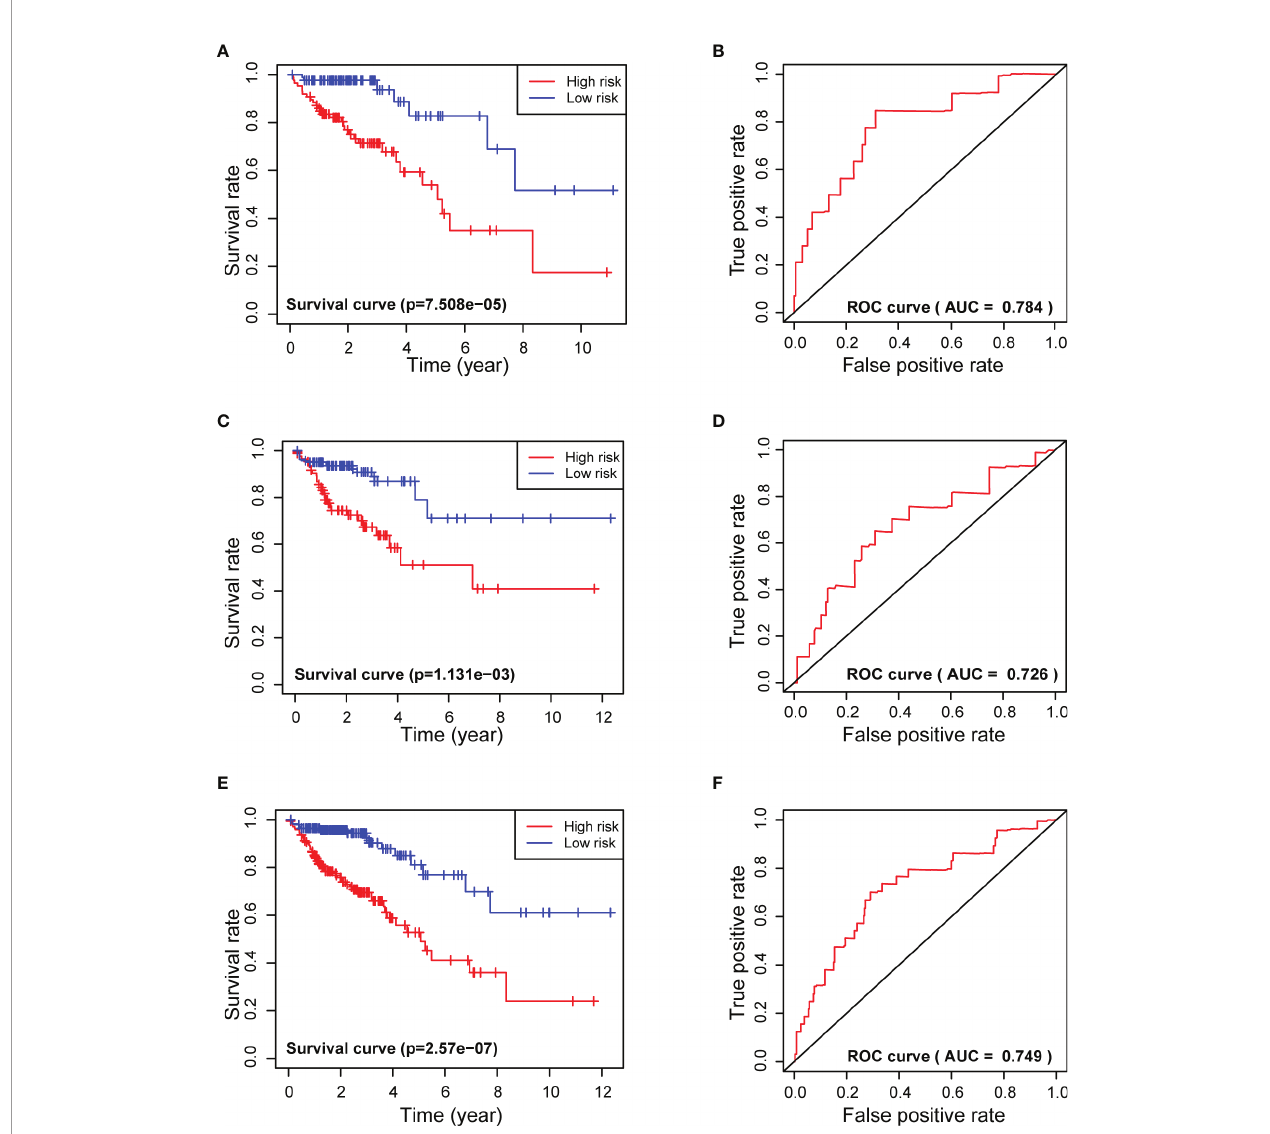
FIGURE 3 | Use of the 7-miRNA Risk Score for analysis of survival times (left) and receiver operating characteristic analysis (right) of the Training Set (A, B) , Testing Set (C, D) , and all patients (E, F) . “ + ” represents censored data in (A, C, E)